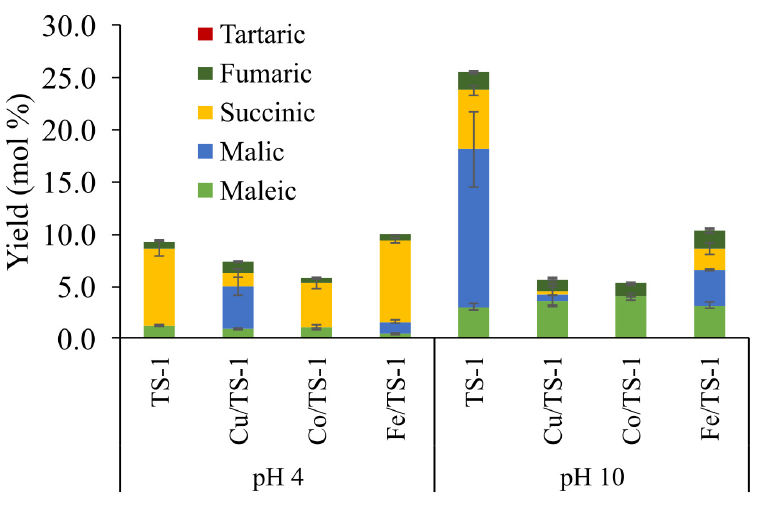
Figure 11. Effect of TS-1 and modified TS-1 catalysts in the C 4 -DCA yields for the wet peroxide oxidation of vanillic acid. (Modified from [101]. Copyright 2020, with permission from Elsevier.) The TS-1 catalyst was used for oxidation of different industrial lignins (Indulin AT ( IAT ), Alkaline lignin ( ALK ), Lignol ( EOL ) lignin, and E. globulus kraft lignin ( EKL )). In this work, Vega-Aguilar et al. [102] evaluated different operating conditions and the catalyst reusability in several cycles. The C 4 -DCA showed a strong dependence on pH, temperature, reaction time, catalyst load, and H 2 O 2 load. The main C 4 -DCA were MAL and SA, and there was an increase in the SA yield between the non-catalyzed and the catalyzed reactions, up to four times for indulin AT and alkaline lignins (Table 2). High temperatures were needed to achieve a good lignin conversion and C 4 -DCA yields, but acid degradation also happened at these temperatures. Acidic and neutral pHs showed the best yields, with the neutral pH being the best operating condition since lignin shows a poor solubility at acidic pH. A 10 wt% H 2 O 2 loading was the optimum amount; a higher amount over-oxidized the products, while a lower one avoided complete conversion. Interestingly, the best reaction parameters were similar to vanillic acid oxidation. The catalyst showed stability and a slight C 4 -DCA yield decrease after five cycles, due to catalyst loss during the centrifugation steps, associated with the small particle size, and not contamination or catalyst degradation. This study showed that TS-1 can be a valuable catalyst to improve SA as the main C 4 -DCA after lignin oxidation, and further studies can be conducted to enhance its use on larger